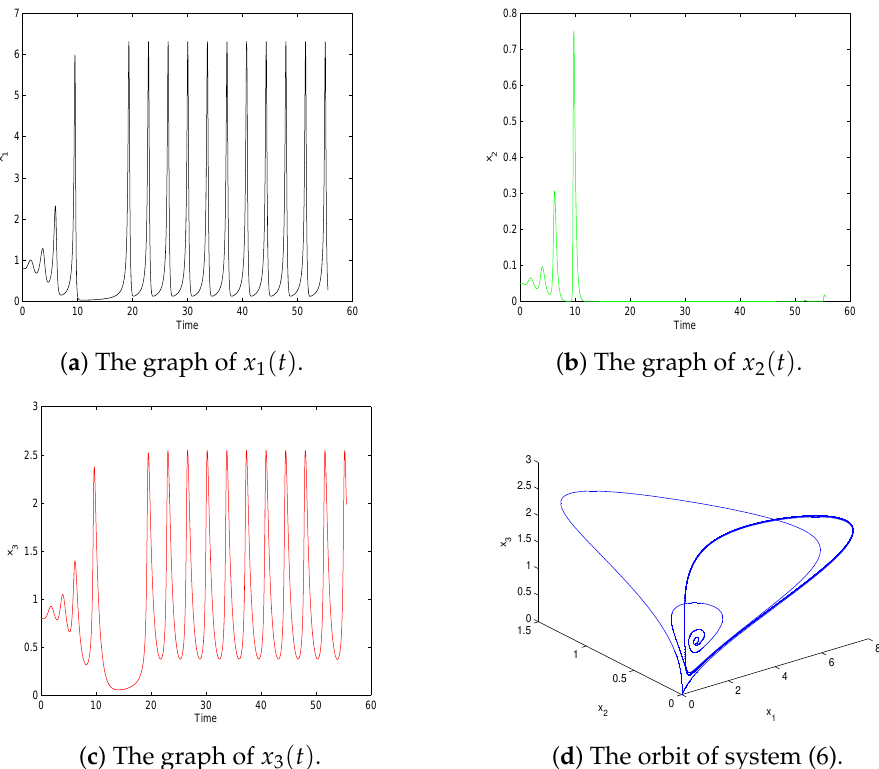
( d ) The orbit of system (6).